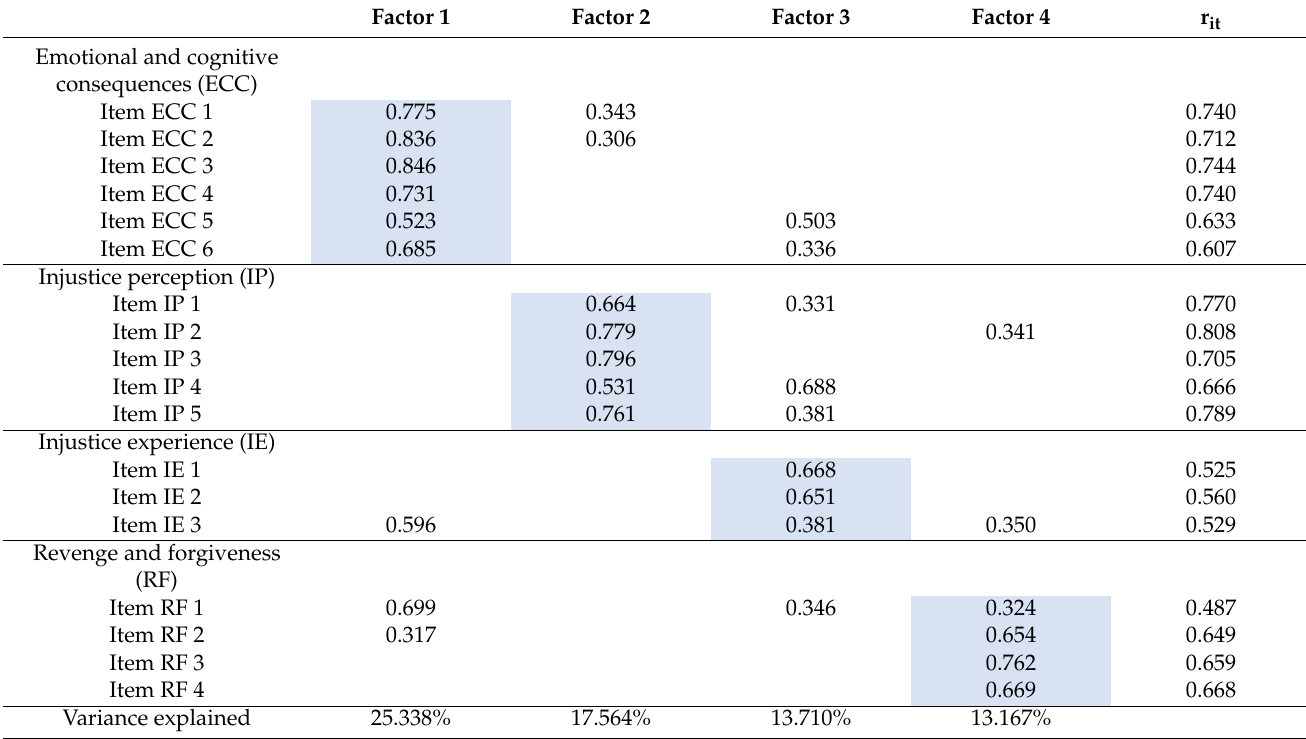
Table 1. Factor loads and discriminatory power (r it